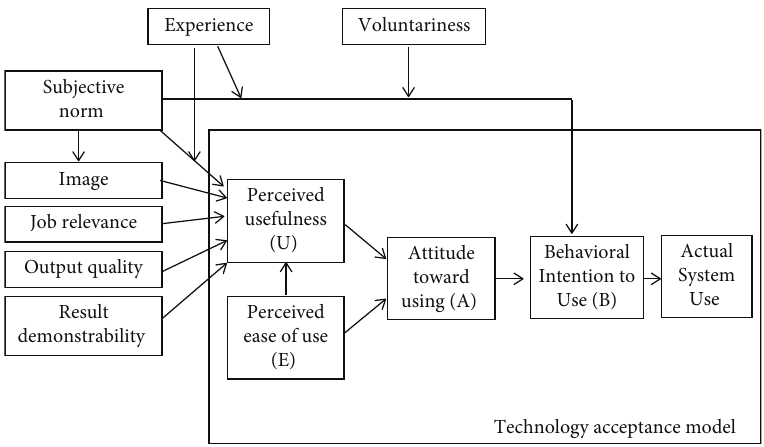
Figure 12: Technology acceptance model (TAM 2)